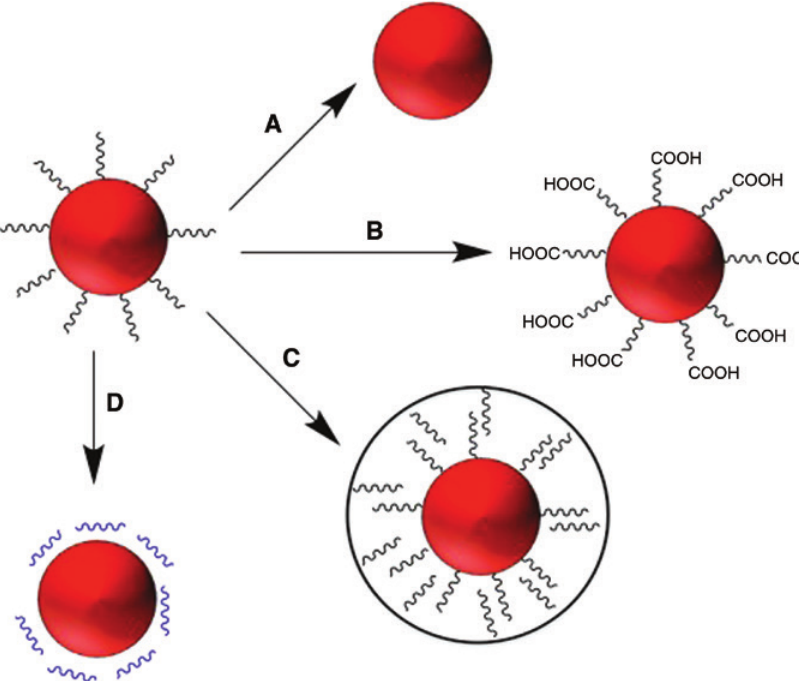
Figure 3: Scheme with some functionalization strategies used for hydrophobic NPs. (A) Removal of the hydrophobic layer; (B) oxidation of the hydrophobic layer; (C) polymer coating; and (D) ligand